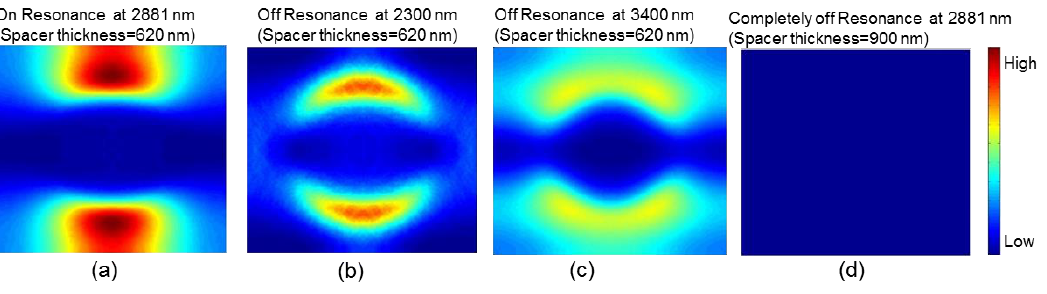
Figure 6. Computed E-field intensity distribution inside the spacer layer in the AZO hole array/spacer/silver stack: ( a ) Mode profile at 2881 nm for the on-resonance case with the spacer thickness = 620 nm; ( b ) Mode profile for off-resonance cases at 2300 nm and ( c ) at 3400 nm with the spacer thickness = 620 nm; ( d ) Mode profile at 2881 nm for the completely off-resonance case with the spacer thickness = 900 nm.